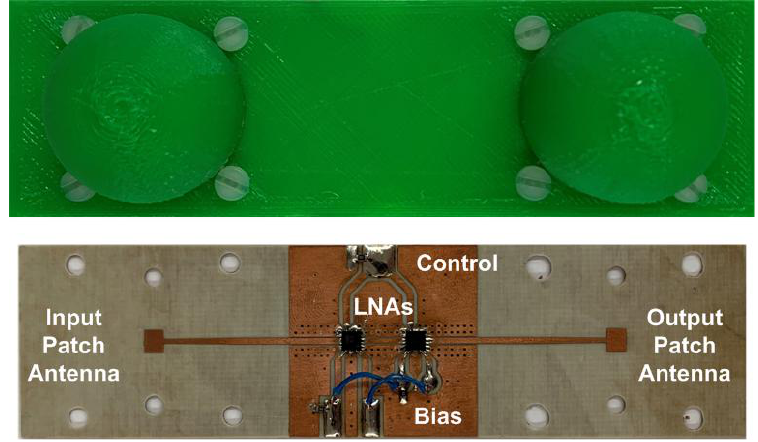
Figure 5. Photography of the microwave front-end of the tag prototype.